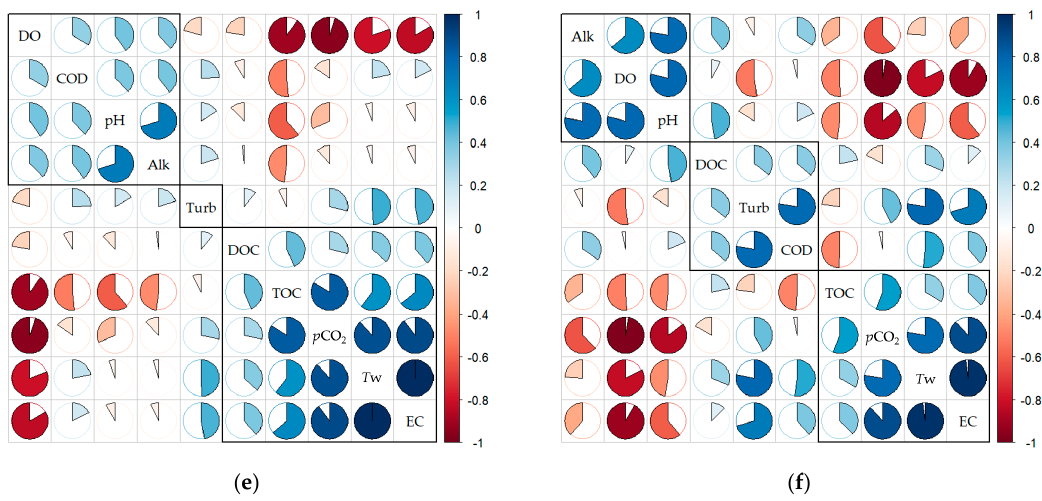
Figure 2. Spearman correlation coefficients between environmental variables and p CO 2 at ( a ) all depths ( n = 45), ( b ) 0 m ( n = 9), ( c ) 5 m ( n = 9), ( d ) 10 m ( n = 9), ( e ) 15 m ( n = 9), and ( f ) 20 m ( n = 9).